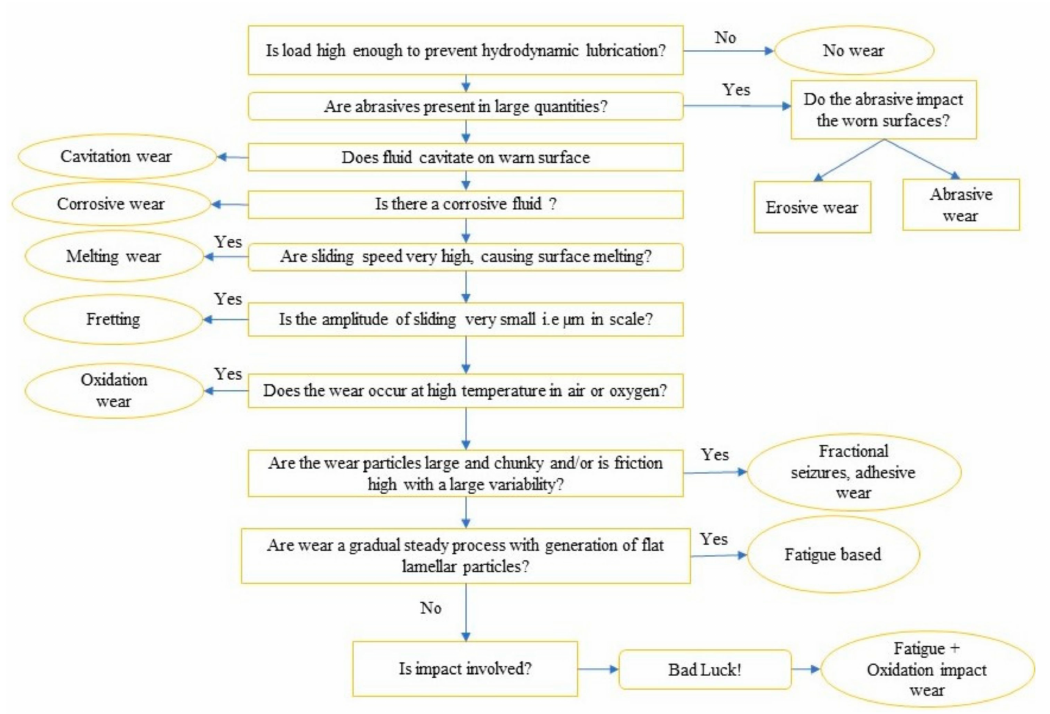
Figure 5. Mechanisms of biomaterial wear behaviour in different conditions (reproduced with permission from ref.